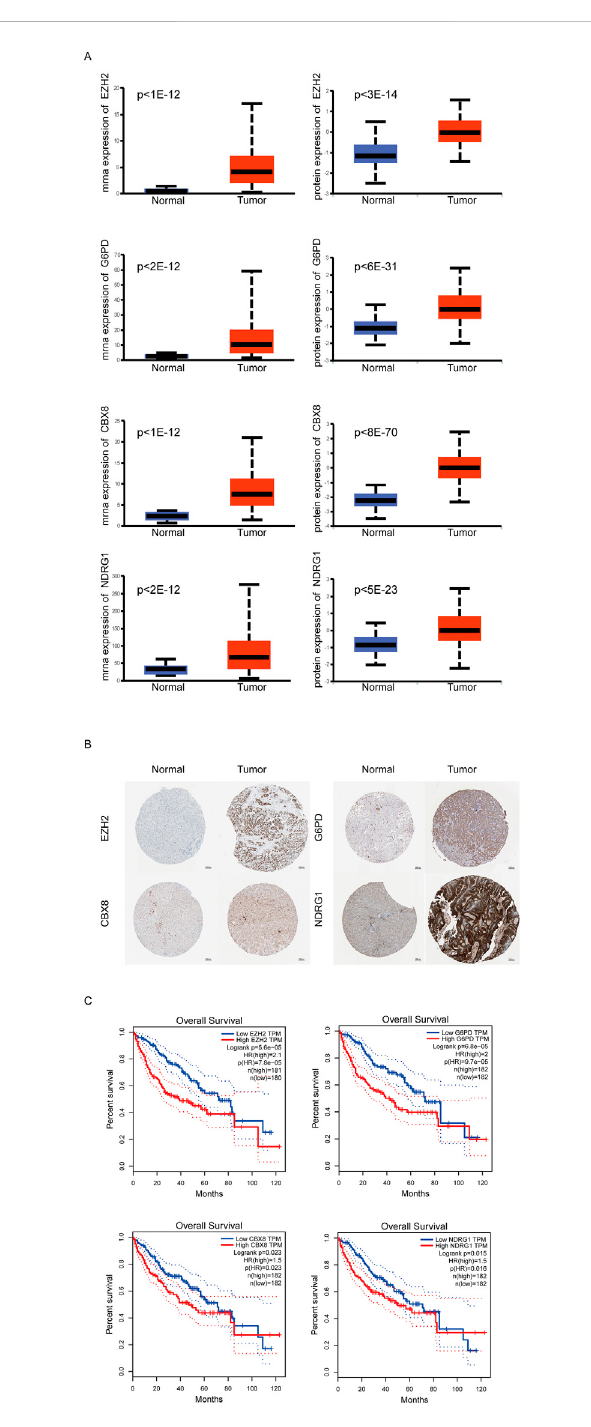
Expression of Key CSGs in HCC. (A) UALCAN analysis of 4 CSGs. (B) IHCof4CSGsbetweenlivercancerspecimensandnormalspecimensin HPA dataset. (C) Overall survival (OS) curves of 4 CSGs in HCC patients.